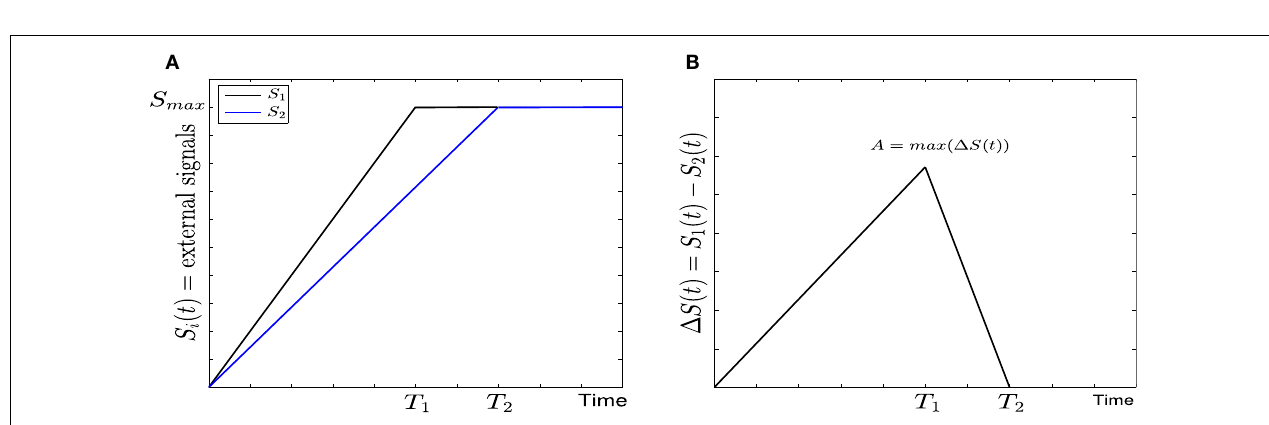
FIGURE 1 | GATA1-PU.1 genetic switch with and without external signals . (A) The isolated switch consists of two transcription factors GATA1 and PU.1 that activate themselves while inhibit each other’s expression. (B) The exposure of the same switch in (A) to two external signals S 1 and S 2 .